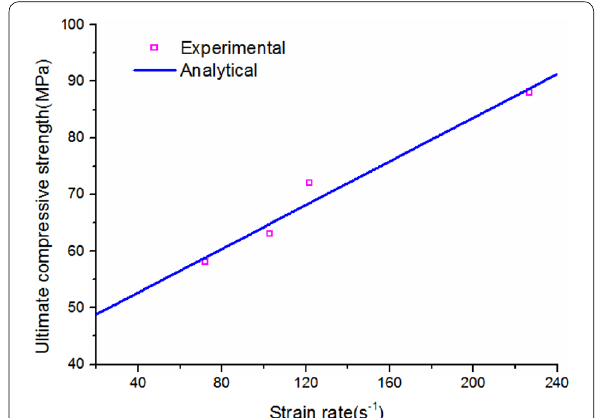
Fig. 15 Ultimate compressive strength–strain rate relationship.